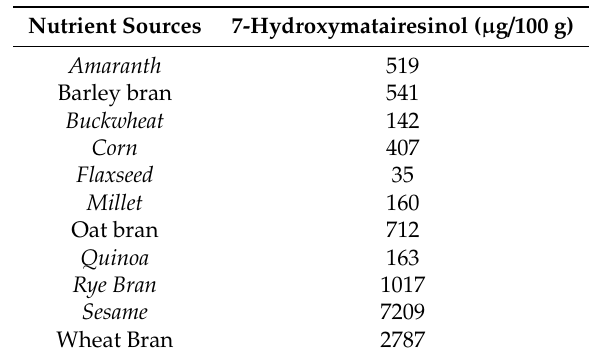
Table 1. Concentration of 7-Hydroxymatairesinol in common nutrient sources. The table presents